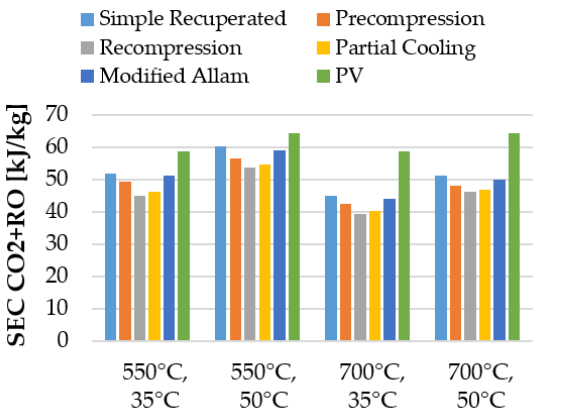
Figure 8. Specific energy consumption [kJ/kg] of fresh water desalination using sCO 2 power cycles and reverse osmosis (including 0.75 kWh/m 3 auxiliary power consumption). Green bars correspond to PV-RO systems with 18% solar-to-electric efficiency.